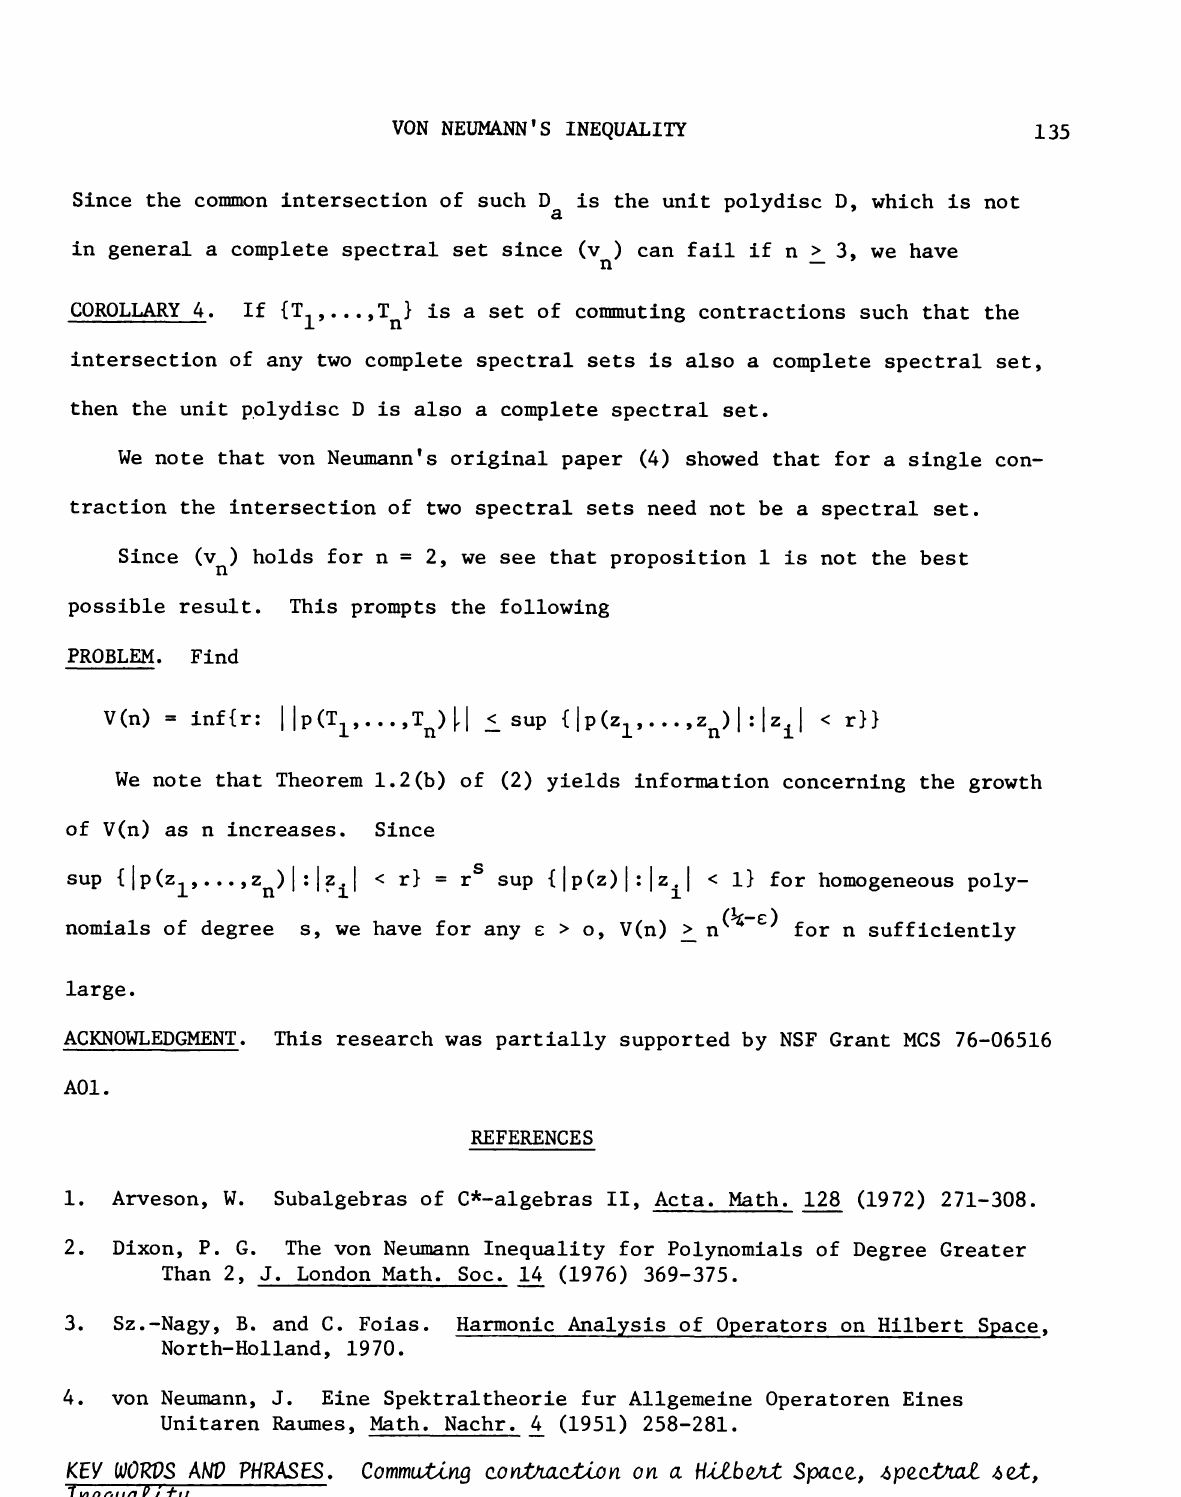
Comming coction on a Hb Space, spe s, nequality. AMS(MOS) SUBJECT